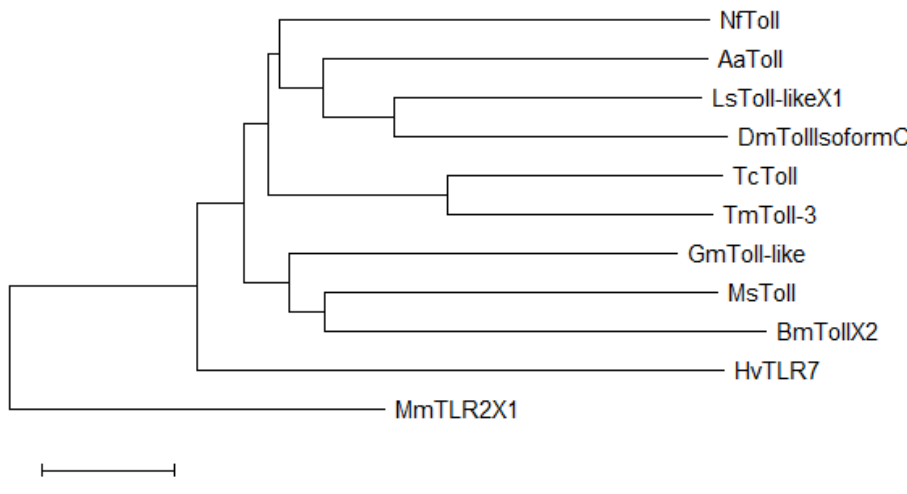
Figure 1. Molecular phylogenetic analysis of TmToll-3 ( T. molitor Toll-3 ) (OP566500). The phylogenetic tree was constructed using MEGA7 using the maximum likelihood method and 1000 bootstrap replicates (the numbers at the nodes indicate bootstrap support). The percentage of trees in which the associated taxa clustered together is shown next to the branches. The phylogenetic tree was constructed based on amino acid sequence alignments using several protein sequences, including those of Tc Toll, Tribolium castaneum protein Toll (XP_967796.2); Dm TollIsoformC, Drosophila melanogaster Toll isoform C (NP_001262995.1); Aa Toll, Aedes aegypti protein toll (XP_021708718.1); Ls Toll-likeX1, Lucilia sericata protein Toll-like isoform (X1 XP_037811182.1); Bm TollX2, Bombyx mori protein Toll